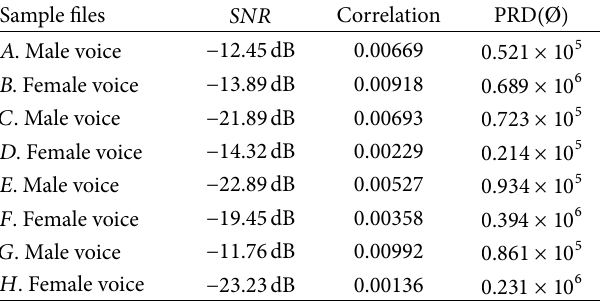
Table 4: Encrypted signal numerical